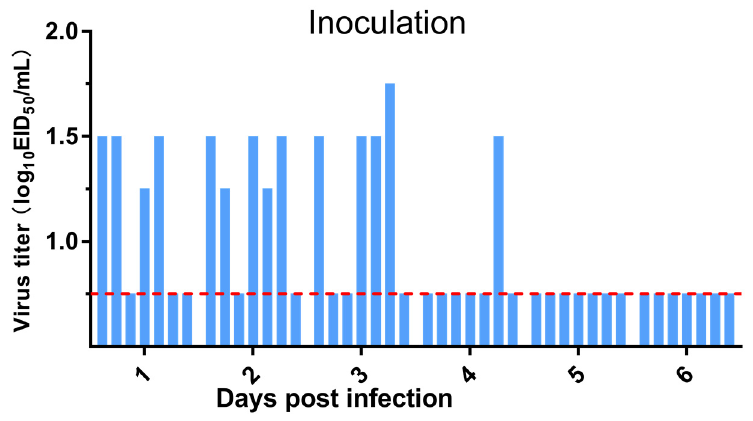
Figure 8. Replication in chickens of H3N2 CIVs. Viral titers in throat and cloacal swabs mixed samples after infection with H3N2 CIVs. A group of seven chickens was inoculated with 3 × 10 6 EID 50 /0.1 mL of the test virus. Each blue bar represents the virus titer in an individual animal. The dashed red line indicates the lower limit of detection. Table 2. Seroconversion of SPF chickens and ducks after H3N2 CIV infection.